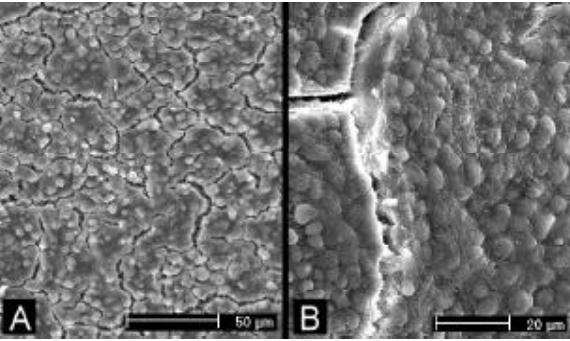
FIGURA 2- grupo 1 – dentes hígidos: A e B: grânulos representando as fibras colágenas rompidas. (A – aumento 400X e B – aumento 800X)